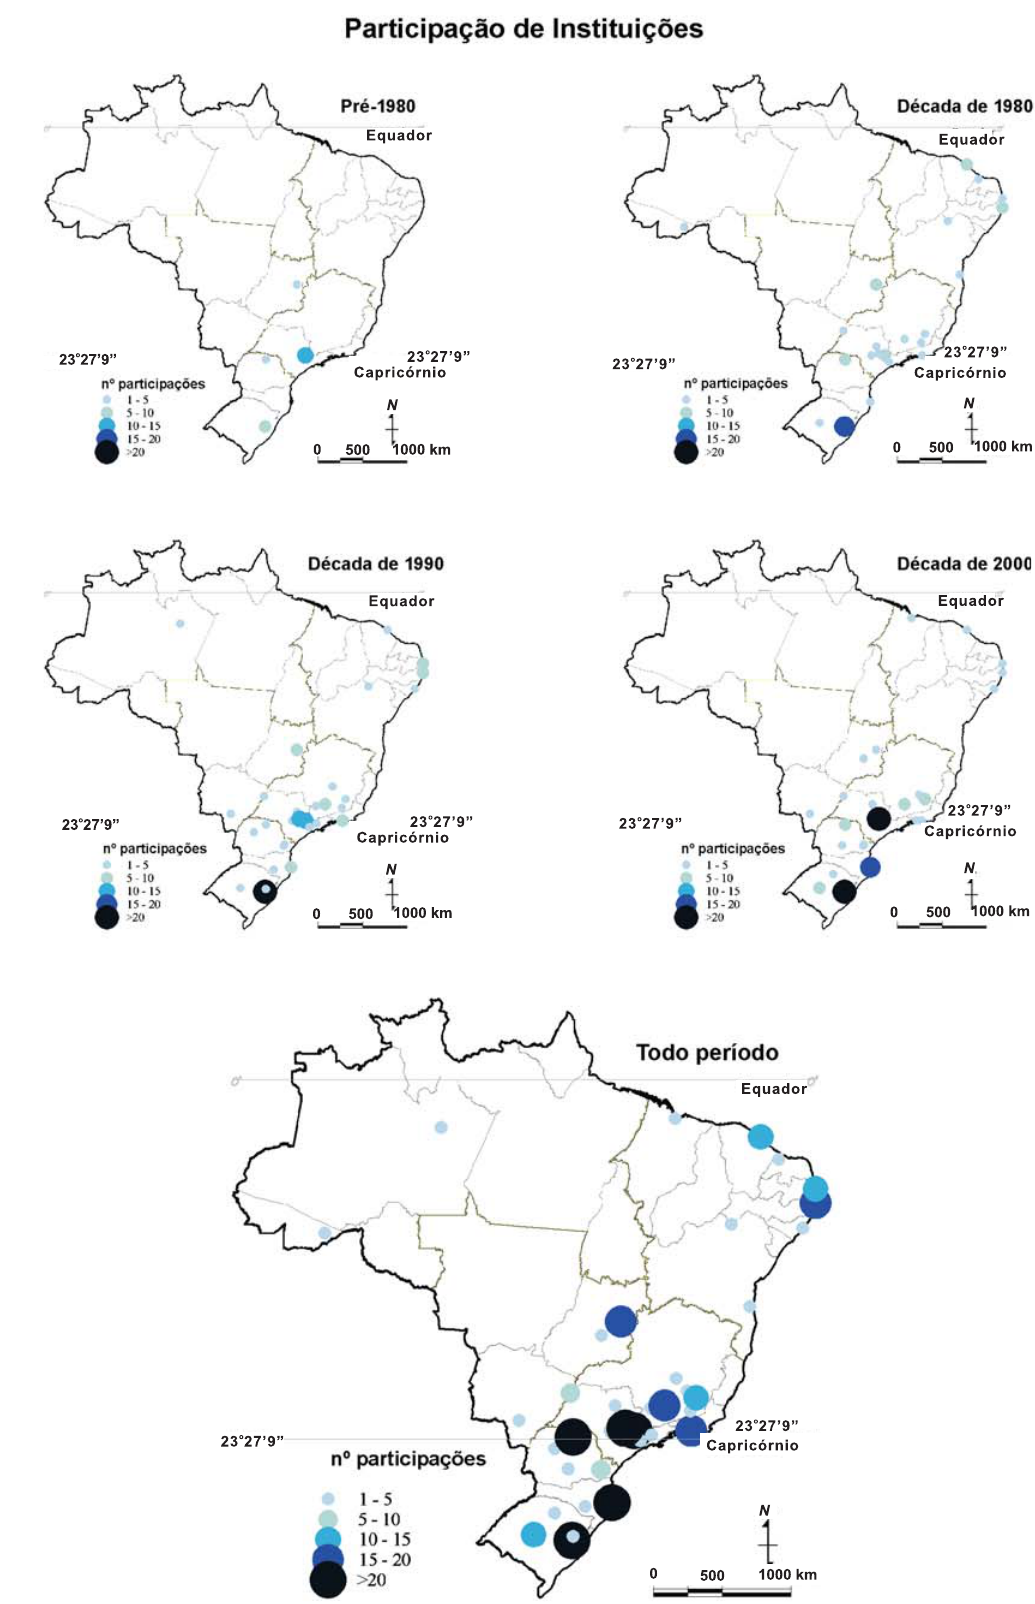
Figura 5. Instituições onde trabalhavam os autores de artigos publicados sobre erosão do solo no